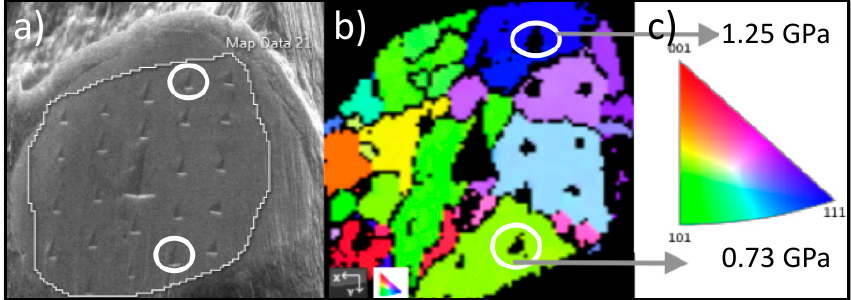
Figure 27. ( a ) SEM micrograph of a particle post-nanoindentation, ( b ) electron back scatter diffraction (EBSD) image showing inverse pole figure (IPF) direction X orientation, and ( c ) color map of Miller indices and hardness of adequate indents.